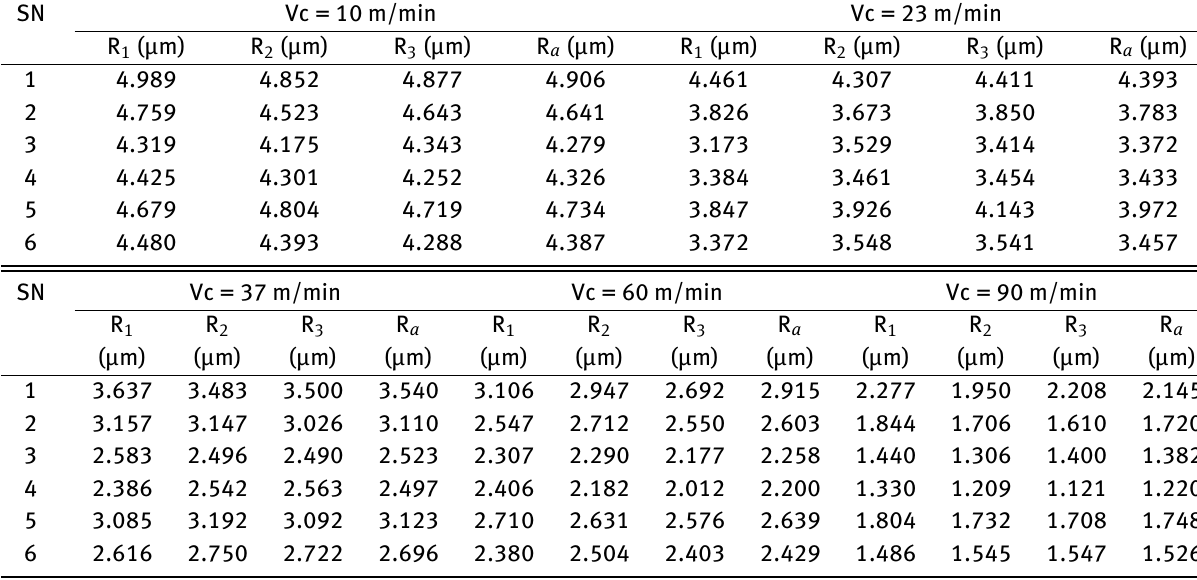
Table 10: Experiments of average surface roughness.